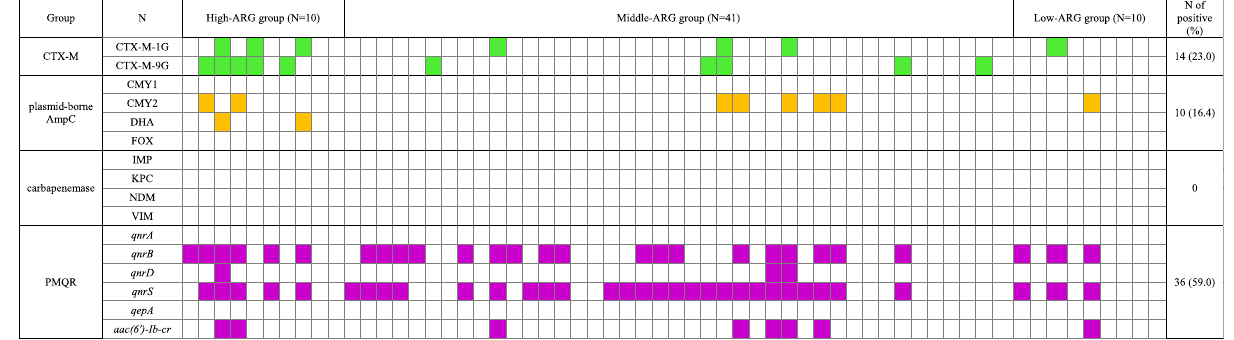
Figure 2. Faecal carriage of alleles of CTX-M, plasmid-mediated AmpC (p-AmpC) plasmid-mediated carbapenemases, and plasmid-mediated quinolone resistance (PMQR) stratified based on the three groups of 61 healthy subjects confirmed by polymerase chain reaction (PCR) and sequencing for each specific allele. HARG, high ARG group; MARG, middle ARG group; LARG, low ARG